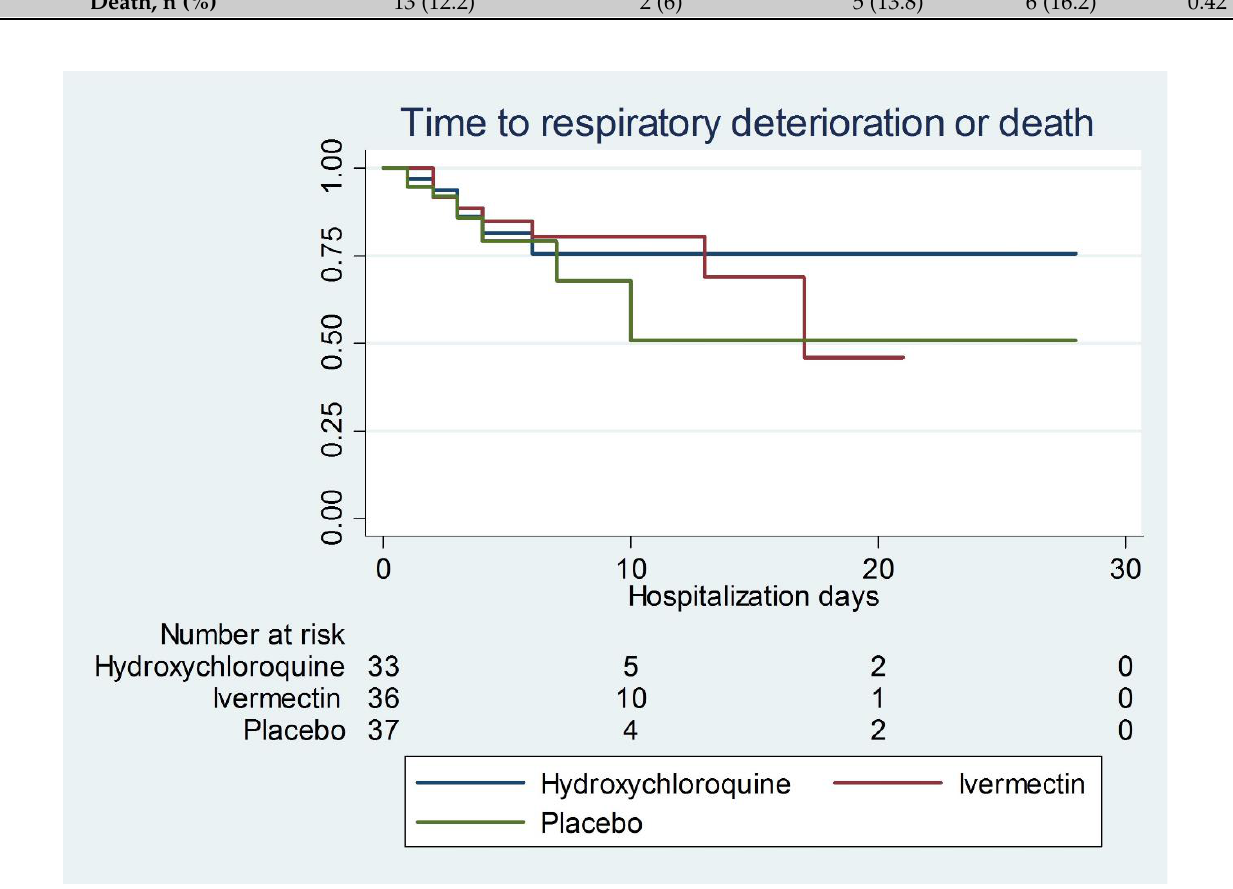
Figure 1. Time to compound outcome of death or respiratory deterioration ( p =